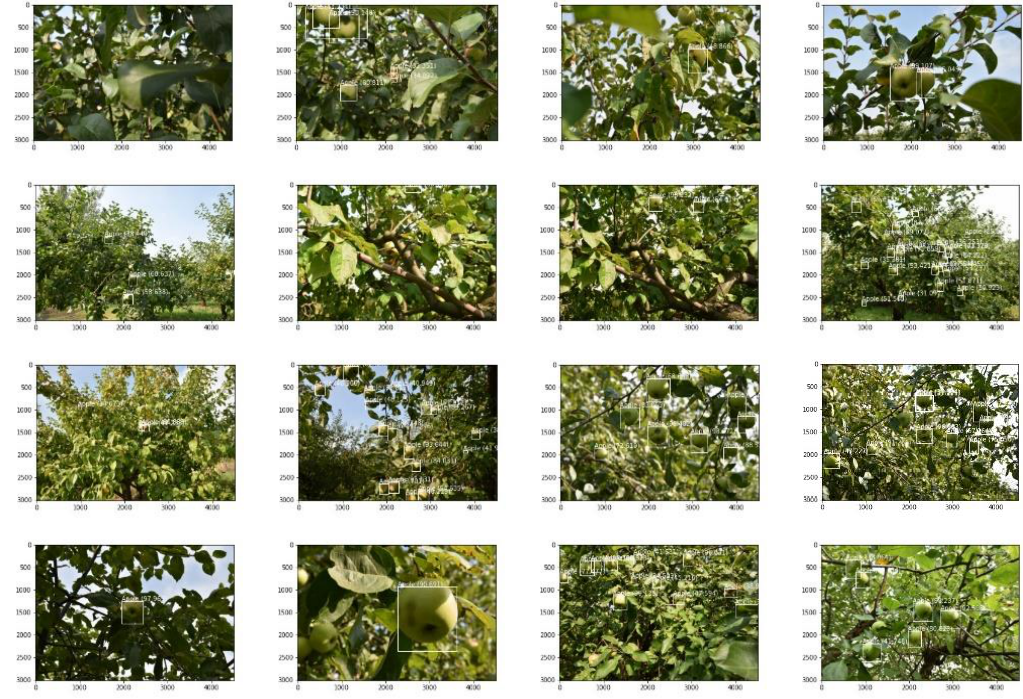
Figure 8. Examples of green apple detection.